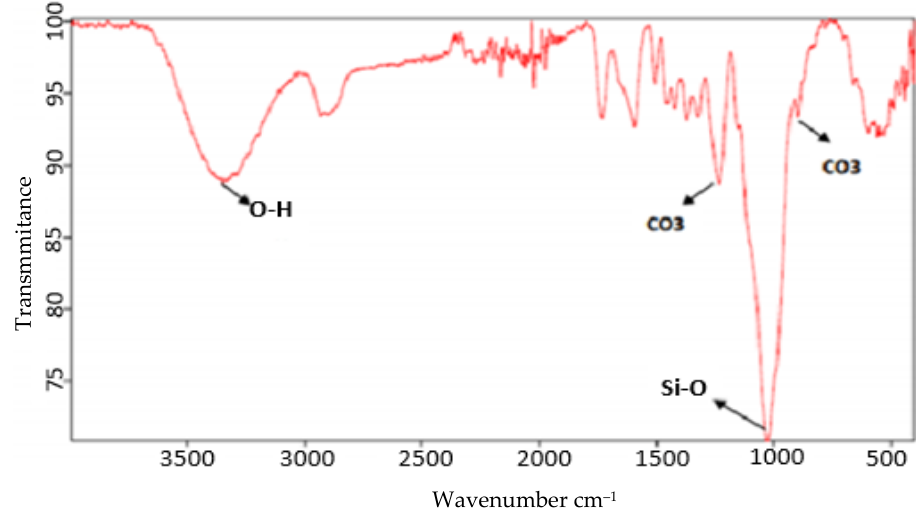
Figure 7. Crystal structure of almond bark by XRD [22]. Figure 3. Crystal structure of almond bark by XRD [16].